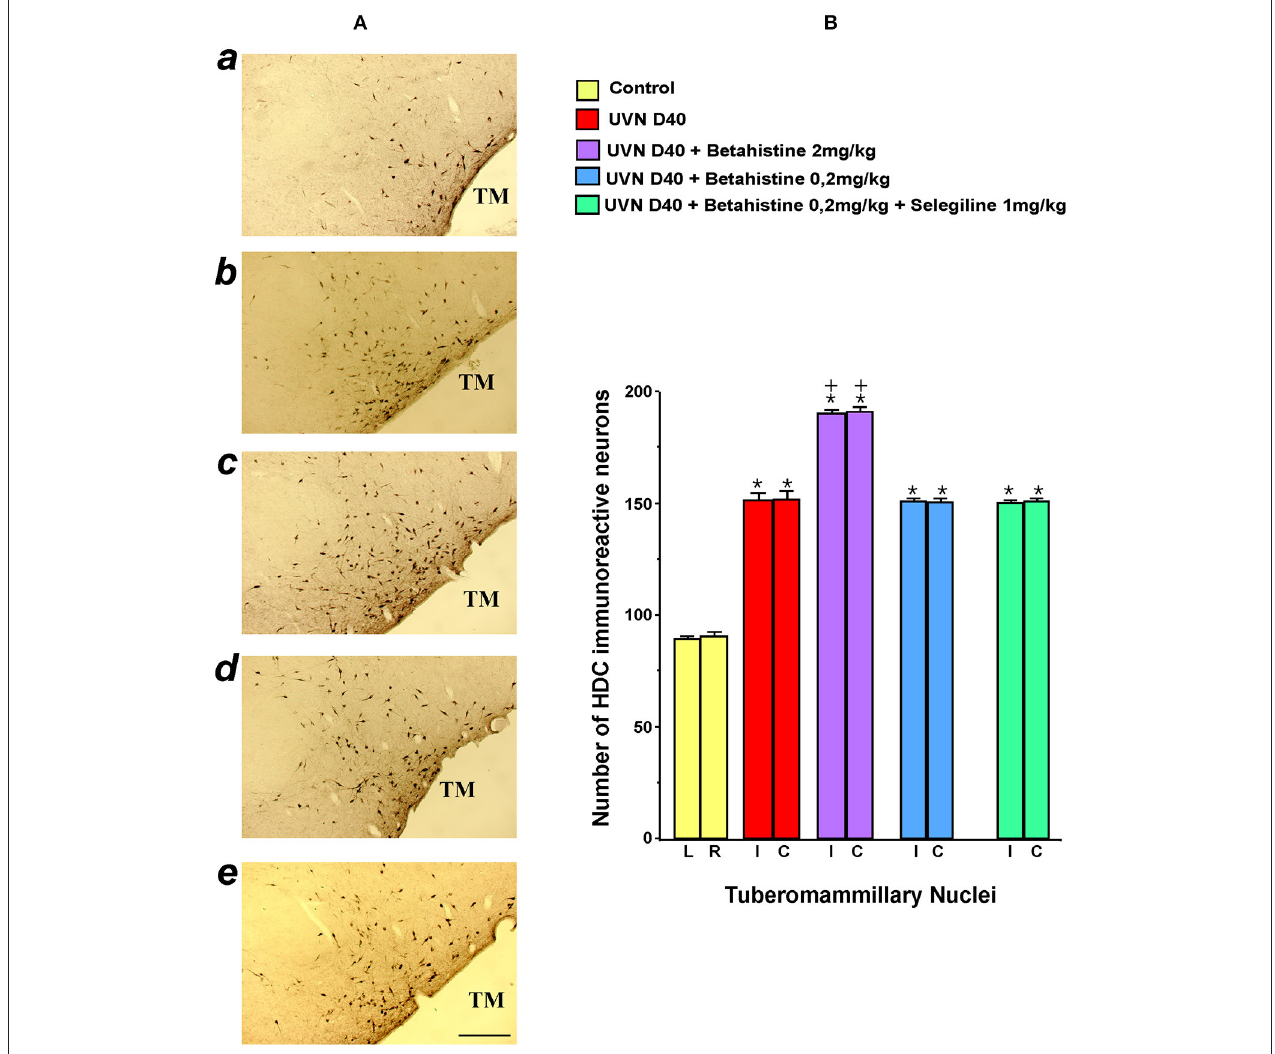
FIGURE 2 | Effects of treatments with different doses of betahistine on the number of histidine decarboxylase immunoreactive neurons in coronal sections of the posterior hypothalamus after unilateral vestibular neurectomy (UVN) in the cat (A) . The typical immunolabeling is illustrated from top to bottom in a representative untreated and unlesioned control cat (a), in a UVN cat killed 40 days after unilateral vestibular neurectomy (b), and in three UVN cats treated with 2 mg/kg of betahistine (c), 0.2 mg/kg of betahistine (d), or with a combination of 0.2 mg/kg betahistine and 1 mg/kg of selegiline (e) and killed at the same survival time. Compared to the control, UVN induces a significant increase in the number of histidine immunoreactive neurons in the tuberomammillary nuclei on both sides at this survival time. A strong and significant bilateral increase in the number of histidine immunoreactive neurons is observed exclusively in the tuberomammillary nuclei of UVN cats treated with 2 mg/kg of betahistine compared to the other treated groups. TM: tuberomammillary nucleus; Bar: 1mm. (B) . The quantitative evaluation of the number of histidine immunoreactive neurons in the tuberomammillary nuclei is provided for the controls and the UVN untreated and treated cats ( N = 3 per group) examined at 40 days survival time, facing the photomicrographs. Data are the mean number of histidine immunoreactive neurons (ordinates). Vertical bars represent the standard errors of the mean. The values are calculated separately for the left and right sides in the control (NS differences) for a direct comparison with the ipsi- and contralateral sides of the other subgroups of animals (UVN D 40 cats, UVN D40 + betahistine 2 mg/kg cats, UVN D40 + betahistine 0.2 mg/kg cats, and UVN D40 + betahistine 0.2 mg/kg + selegiline 1 mg/kg). Note the strong and significant bilateral increase in the number of immunoreactive HDC neurons in the TM of The UVN cats compared with the control ( P < 0.0001) and of the UVN cats treated with 2 mg/kg of betahistine compared to all the other groups ( P < 0.0001). + P < 0.0001 vs. all the groups; * P < 0.0001 vs. control